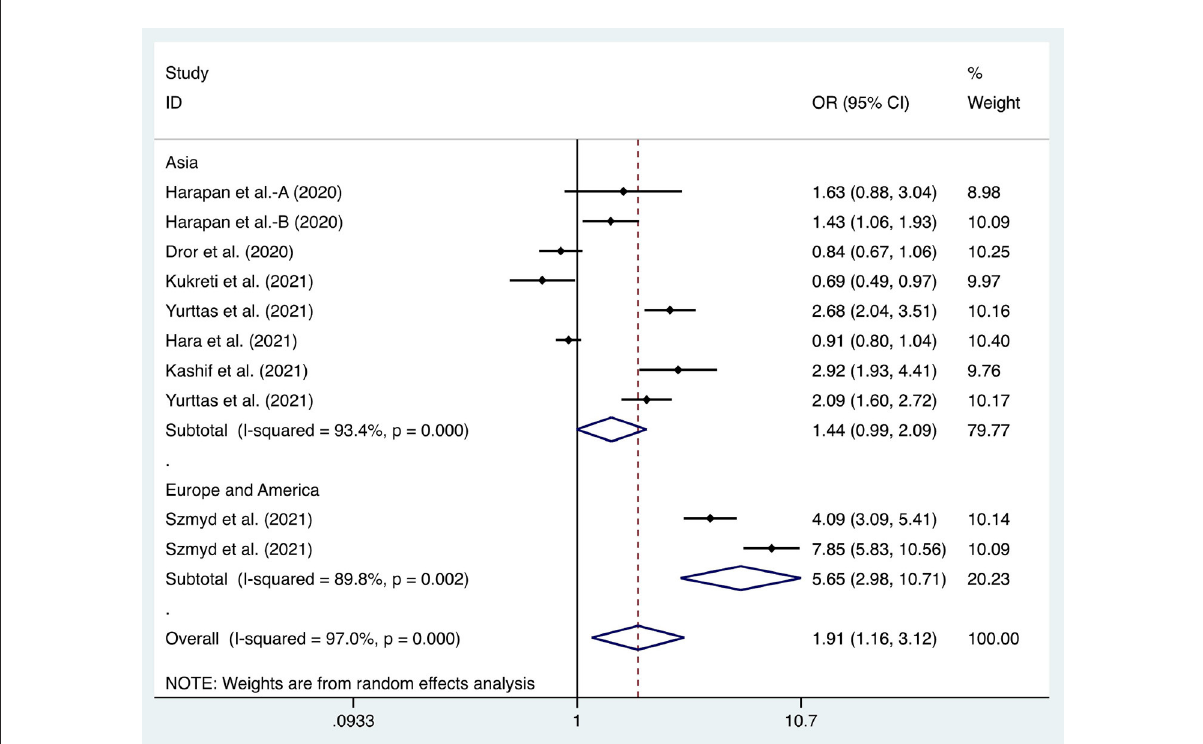
FIGURE5 Forest plot of the willingness of healthcare workers (HCWs) and non-HCWs to receive coronavirus disease 2019 vaccines.